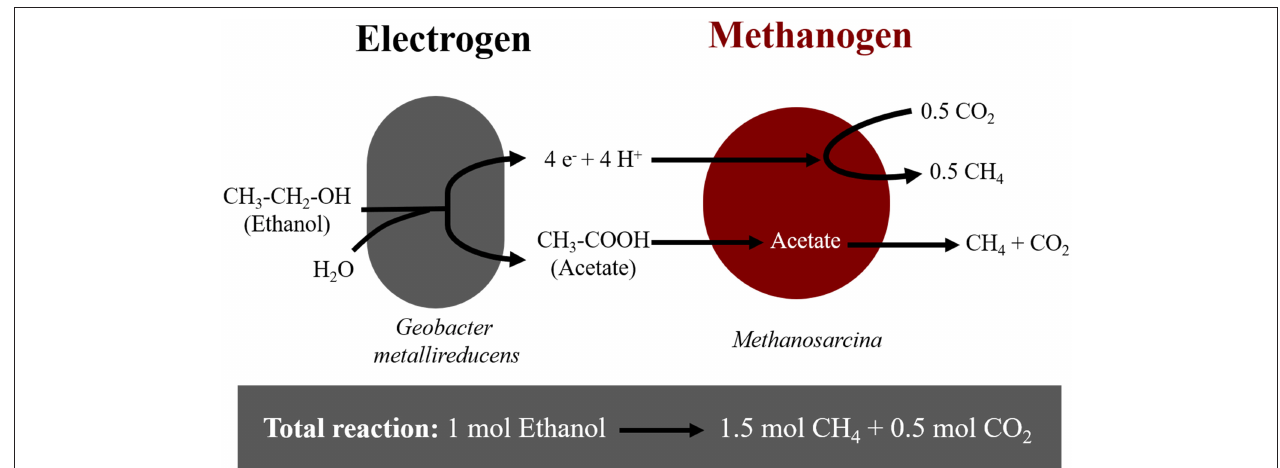
FIGURE 1 | Diagram of electron flow during DIET interactions between Geobacter metallireducens and Methanosarcina -species provided with ethanol as sole electron donor.